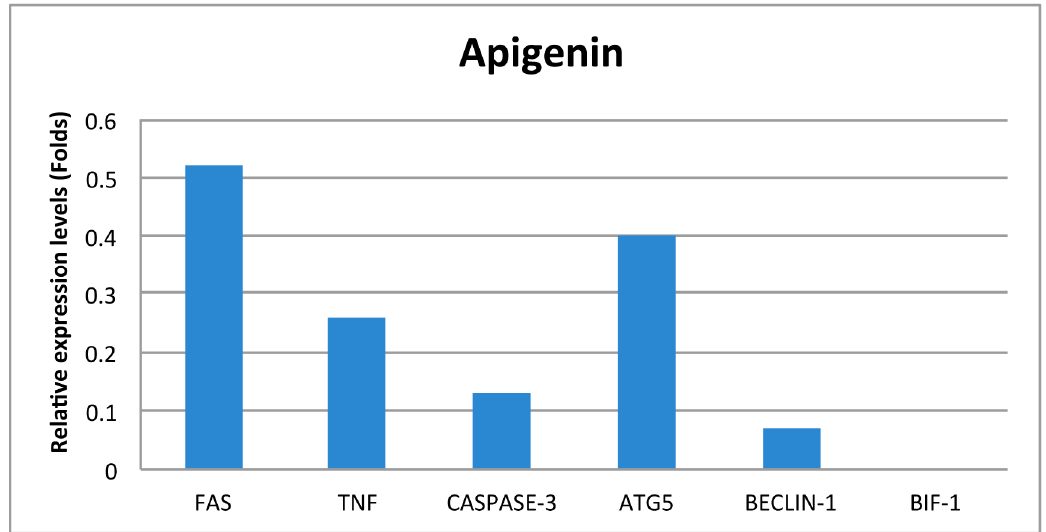
Figure 3. Expression levels of the genes after Apigenin treatment in Hela